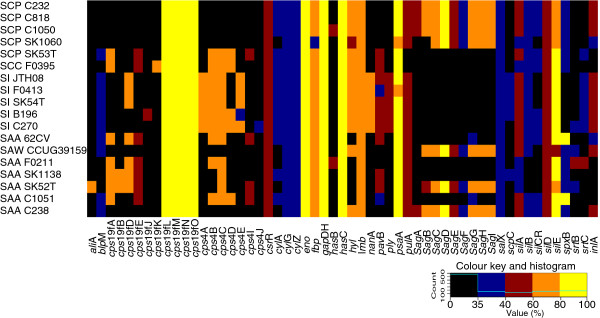
Streptococcus virulence protein detection within SAG, S. gordonii and S. sanguinis strains. A total of 66 Streptococcus genomes (Additional file 2) were queried using a custom virulence database (VirDB) of 189 known Streptococcus virulence determinants (Additional file 6) and a heatmap was constructed to demonstrate relatedness of virulence determinants within each queried strain. The legend on the lower right hand corner depicts the PID of the ortholog from the specific strain to the reference protein within the VirDB and the sum of hits (histogram). The heatmap uses 5 colors to represent percent protein identity as follows: SCP, S. constellatus subsp. pharyngis; SCC, S. constellatus subsp. constellatus; SI, S. intermedius; SAA, S. anginosus subsp anginosus; SAW, S. anginosus subsp. whileyi; Black loci not present (0-35%), Blue (36-40%), Red (40-60%), Orange (60-80%) and Yellow (80–100).